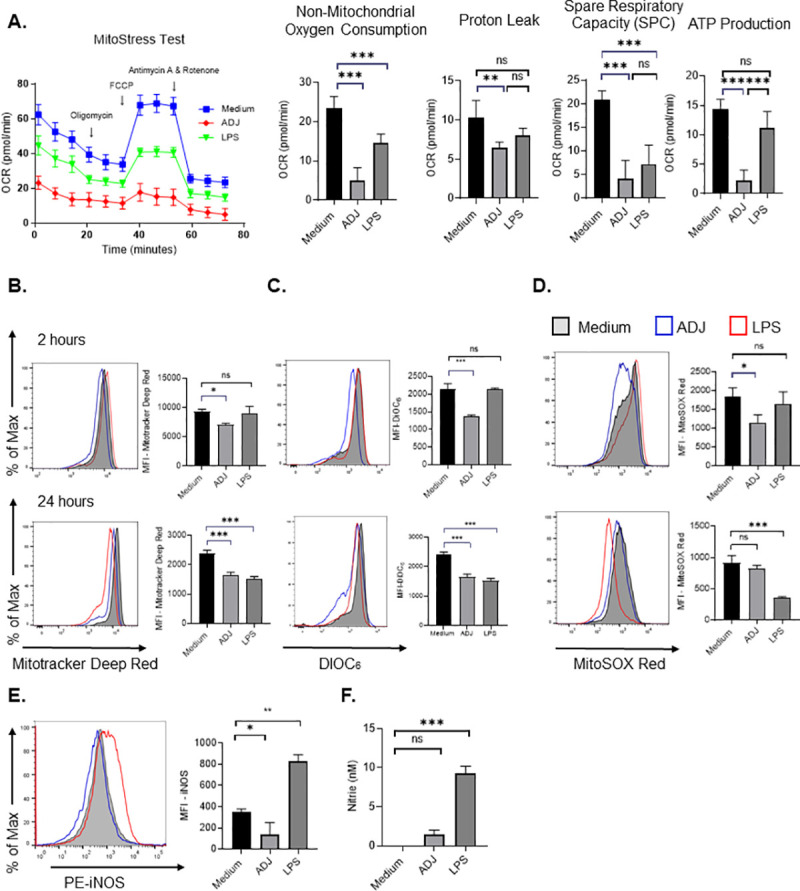
Carbomer-based adjuvant suppresses oxidative phosphorylation in DCs by iNOS-independent mechanisms.(A) BMDCs (7x104 cells/well) were treated with media, ADJ (1%) or LPS (100ng/ml) for 24 h; real-time OCR was determined during sequential treatments with oligomycin, FCCP, and antimycin-A/rotenone. Basal respiration, maximal respiration and spare respiratory capacity (SRC). SRC were calculated as the difference in OCR after addition of FCCP and OCR before the addition of oligomycin. (B-D) BMDCs (2x105 cells/well) were treated with media, ADJ (1%) or LPS (100ng/ml) for the indicated time periods (2 or 24 h) and stained with Mitotracker Deep Red, DiOC6, MitoSOX Red Mitochondrial Superoxide Indicator to quantify mitochondrial mass, membrane potential or mitochondrial superoxide, respectively. (E) Culture supernatants from DCs cultured with ADJ (1%) or LPS (100ng/ml) were analyzed for nitrite using Griess reagents. (F) iNOS expression in unstimulated, ADJ (1%)- or LPS (100ng/ml)-stimulated DCs at 24 h, was determined by intracellular staining using Cytofix/perm kit. Data are representative of 2–3 independent experiments. Error bars are SEM; *P<0.01; **P<0.001; ***P<0.0001 (A-F; one-way ANOVA).